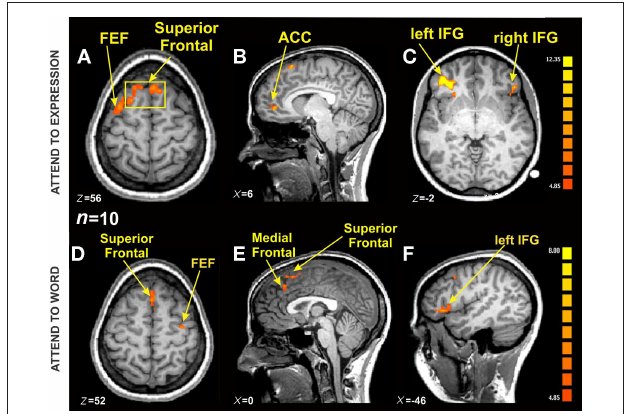
FIguRe 5 | fMRI BOLD activation from Incongruent blocks compared with Congruent blocks in the expression and Word instruction conditions [ n = 10, p (Bonferroni) < 0.05]. (A) Axial view showing the same Superior Frontal activation from (B) (yellow square), and a lateralized FEF activation on the left hemisphere (TAL coordinates: x = 5, y = 22, z = 56). (B) Sagittal view centered on ACC on the right hemisphere (TAL coordinates: x = 6, y = 45, z = 1). (C) Axial view showing bilateral IFG activation (TAL coordinates: x = − 39, y = 39, z = − 2). (D) Axial view showing Superior Frontal activation, and a lateralized FEF activation on the right hemisphere ( x = 0, y = − 20, z = 52). (e) Sagittal view centered on Superior and Medial Frontal regions (TAL coordinates: x = 0, y = − 9, z = 22). (F) Sagittal view centered on the left IFG (TAL coordinates: left IFG TAL coordinates: x = − 46, y = 36, z =